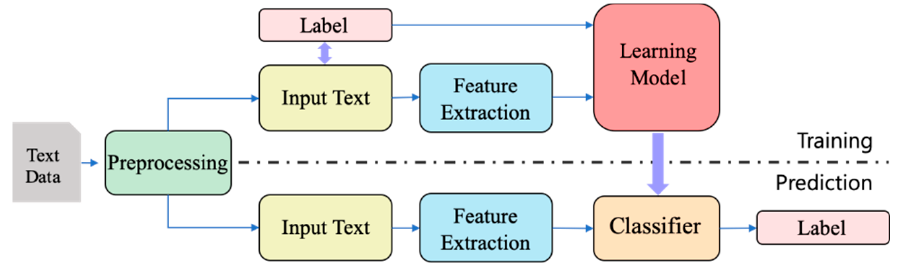
Figure 2. Structure of Content Auto Classification.